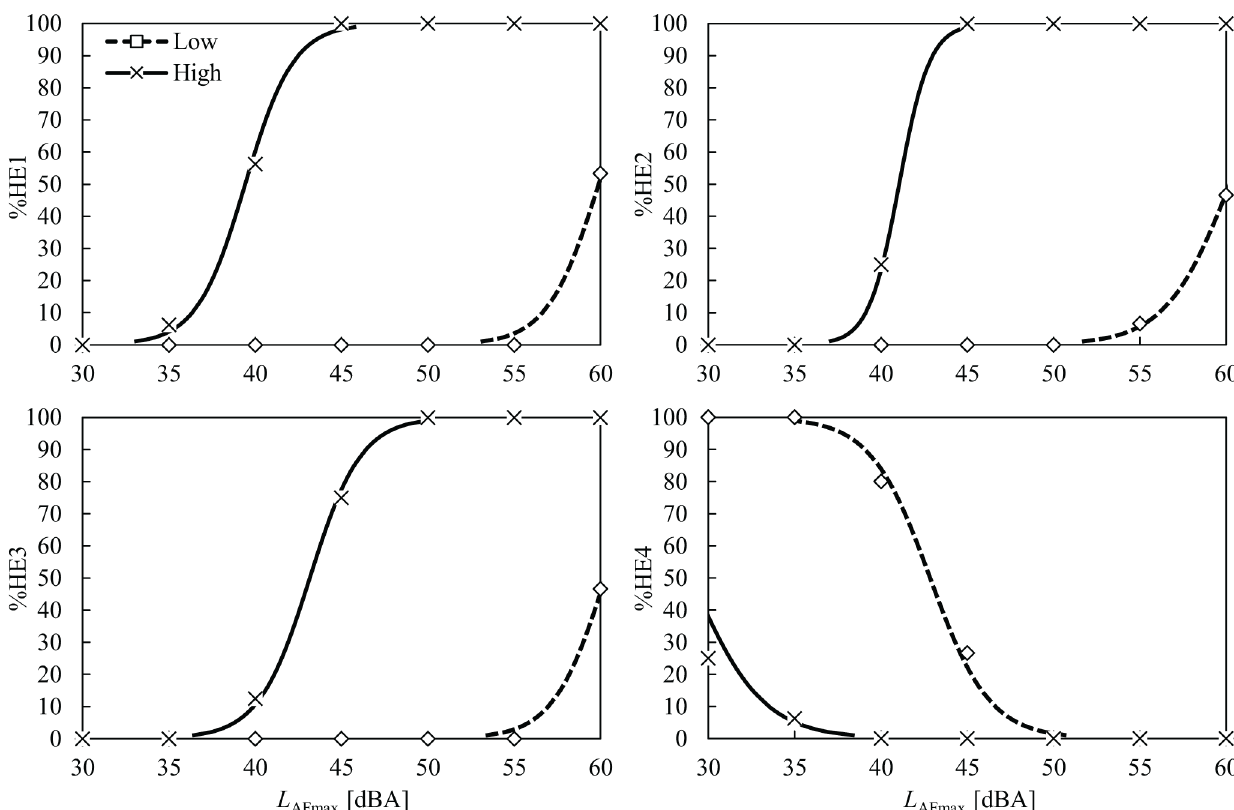
Fig 6. Percentage of high emotion ratings (%HE1–%HE4) for the low ( □ ) and high ( × ) noise-sensitivity groups as a function of noise level. Probit regression curves are also presented for both groups.